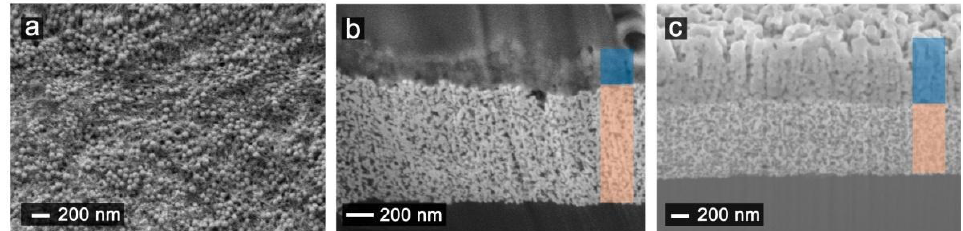
Figure 7. ( a )Top view SEM images of surface of 12-layer SWCNT-SNP-HRP printed electrode. ( b , c ) Focused ion beam cross-section image of electrodes printed showing the different layers and SiO 2 nanoparticles for ( b ) a 6-layer SWCNT-SNP-HRP (7.5 mg/mL of SWCNTs and 1 mg/mL of SNP-HRP) printed electrode and ( c ) of 12-layer SWCNT-SNP-HRP (5 mg/mL of SWCNTs and 5 mg/mL of SNP-HRP) printed electrode. Orange and blue shades correspond to printed Au and SWCNT-SNP-HRP films, respectively.